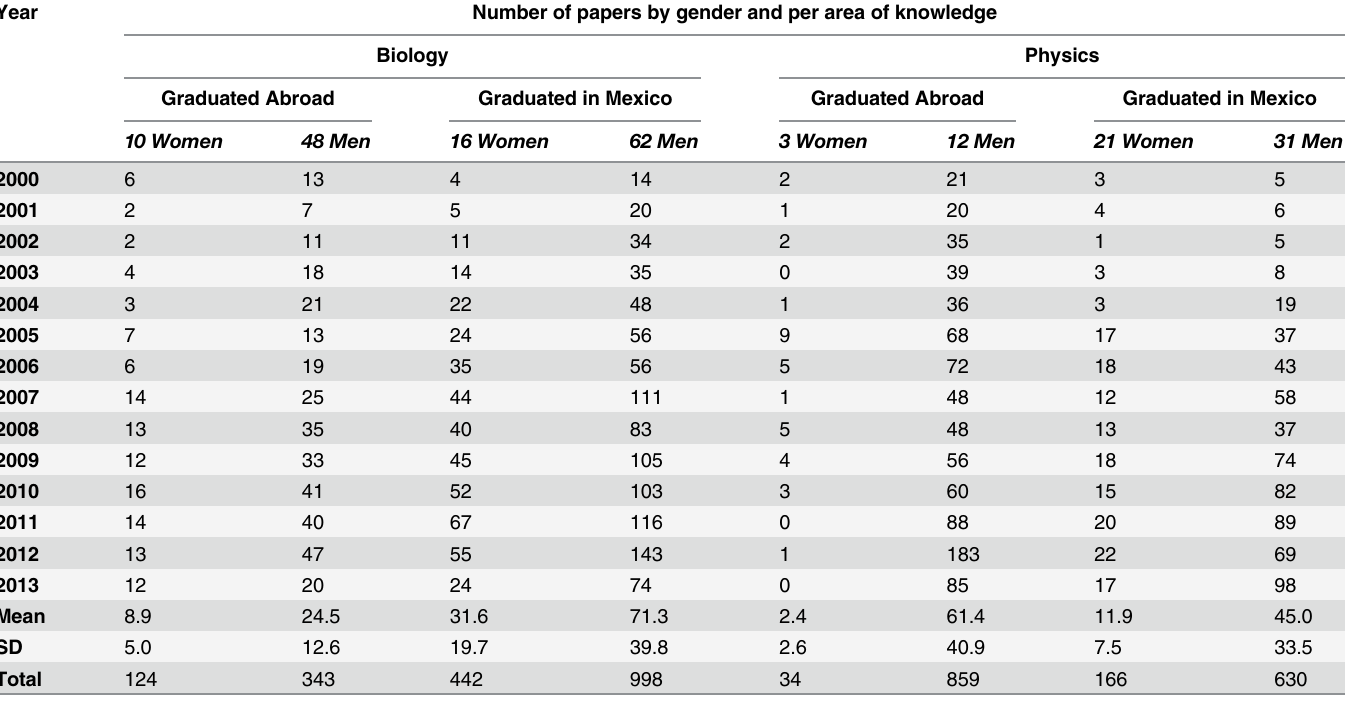
Table 11. Distribution of the number of papers published by the researchers in biological sciences and physics during the period 2000 – 2013. Year Number of papers by gender and per area of knowledge